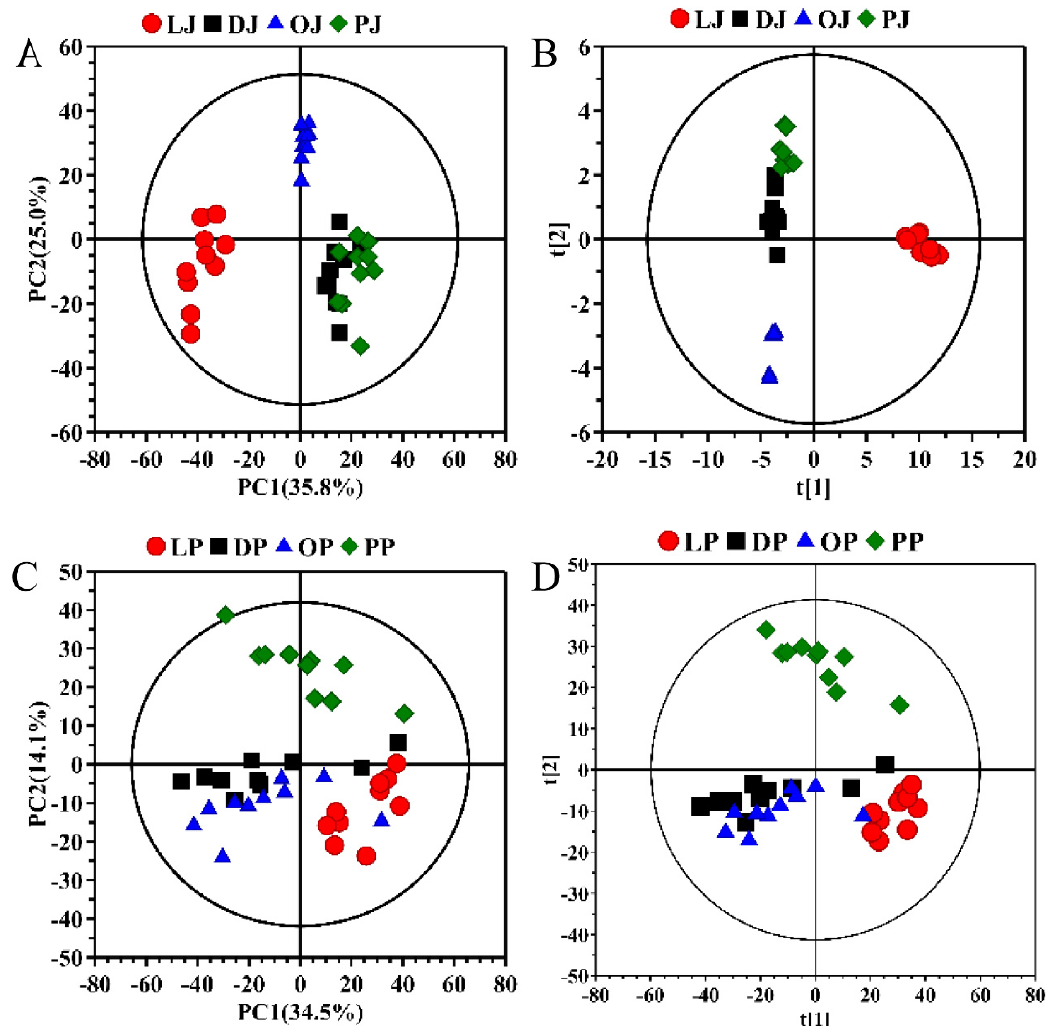
Figure 2. Two-dimensional PCA ( A , C ) and PLS-DA ( B , D ) score plots of different citrus juices ( A , B ) and pericarps ( C , D ). LJ: lemon juice; DJ: dekopon juice; OJ: sweet orange juice; PJ: pomelo juice; LP: lemon pericarp; DP: dekopon pericarp; OP: sweet orange pericarp; PP: pomelo pericarp. To screen out the most significant differential components in each citrus juice, four OPLS-DA models were established on the pair-wise sample groups including lemon vs.